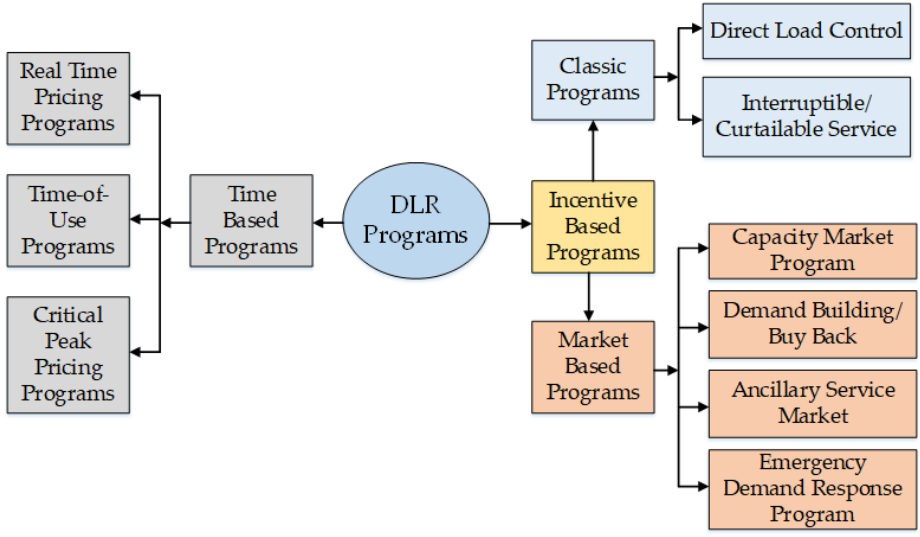
Figure 15. Classification of various best demand response load (DRL) strategies for stochastic profit-based scheduling approach in virtual power plants (Redrawn with permission from [48], 2016, Elsevier).